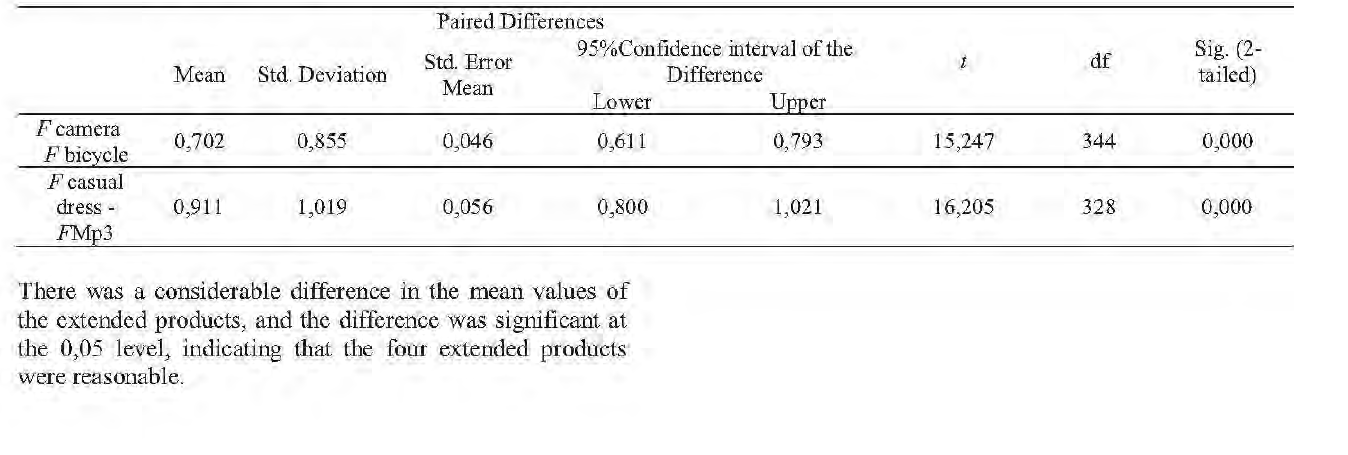
Table 1: Paired samples